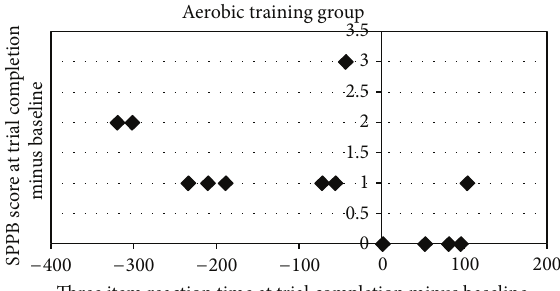
Figure 4: Significant correlations between change in reaction time performanceonthespatialmemorytaskandchangeinperformance on the SPPB for the AT group. SPPB performance was negatively correlated with spatial memory reaction time, where better balance and mobility were associated with faster reaction